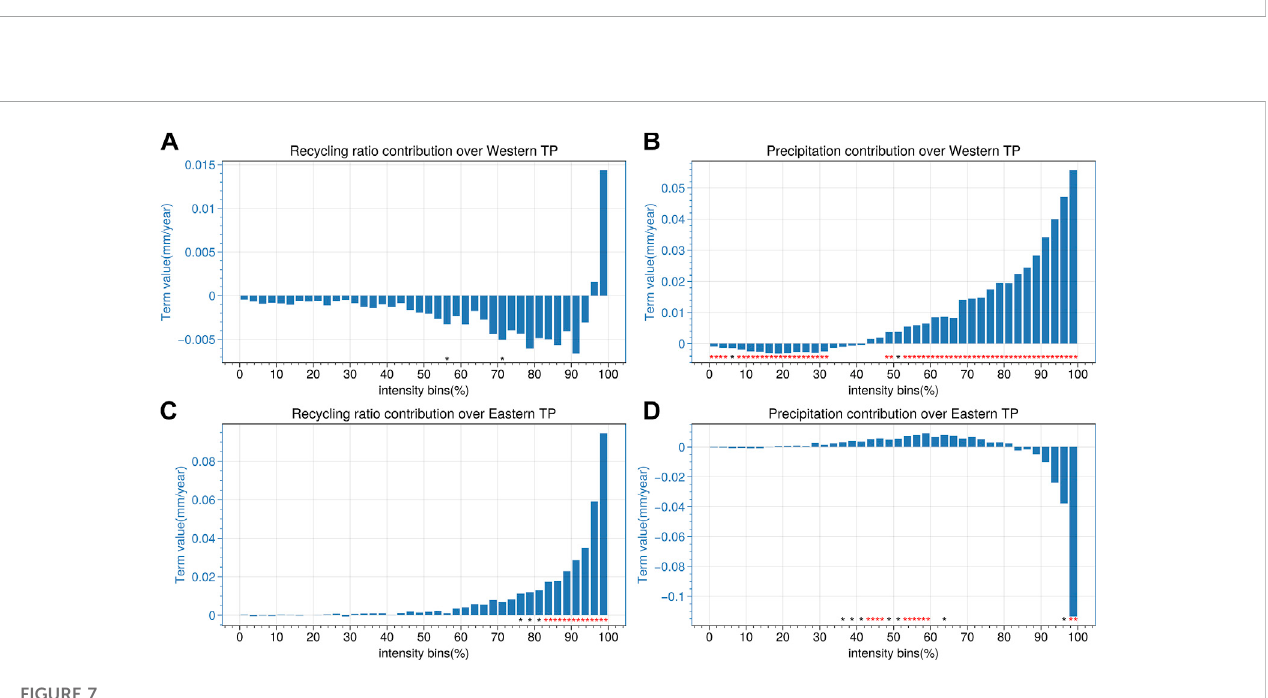
FIGURE 6 Decomposition of internal precipitation trends to the PRR and precipitation over the TP. In (A,B) histograms represent the contribution of PRR and precipitation to the internal precipitation over the TP. The red stars and black stars indicate statistical signi fi cance exceeding 95% and 90%, respectively.